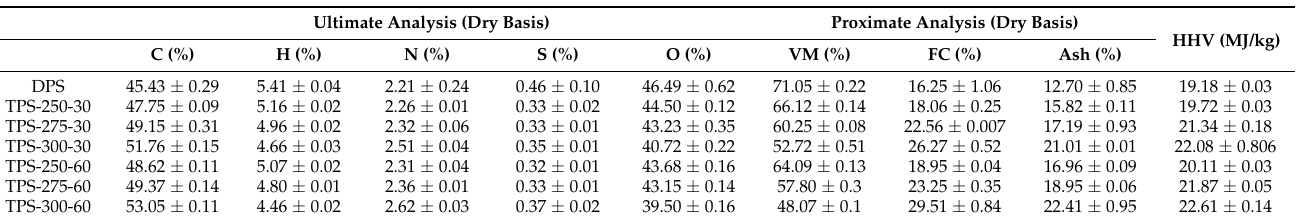
Table 2. Ultimate analysis, proximate analysis and heating values of dried and torrefied pulp industry